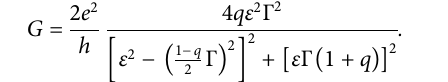
From above equation, one can see that G develops a dip at ε (cid:1) 0, and has two resonances located at ε (cid:1) ± ( 1 − q ) Γ / 2 as shown by the red dashed and blue dotted lines in Figure 2A . For the two dots are coupled to the dots symmetrically q (cid:1) 1, the conductance exhibits a single wide peak centered at as indicated by the green dash-dotted line, which can also be seen from Eq. 5 . Under the condition of t c ≠ 0, the conductance is composed by one Breit- Wigner resonance at ε (cid:1) t c and a Fano one at ε (cid:1) t c , which respectively correspond to the bonding and antibonding states in